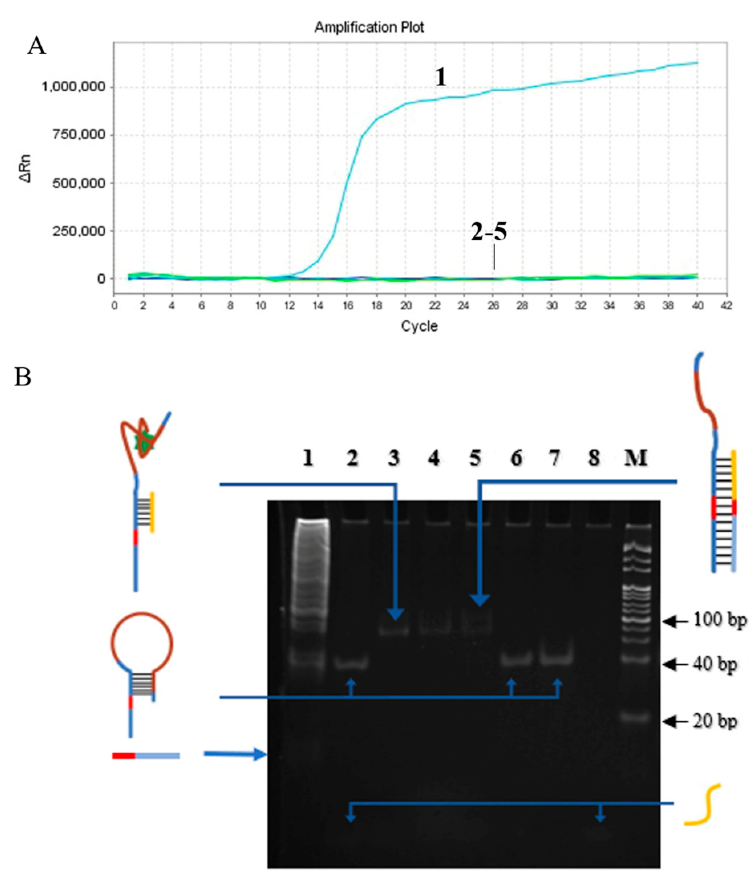
Figure 1. Feasibility verification of the fluorescent aptasensor. ( A ) Real-time fluorescence curve verification. ( B ) Feasibility verification of the fluorescent aptasensor by polyacrylamide gel elec- trophoresis. 1: OTA + HP + primer + DNA polymerase + nicking endonuclease, 2: HP + primer + DNA polymerase + nicking endonuclease, 3: OTA + HP + primer, 4: OTA + HP + primer +